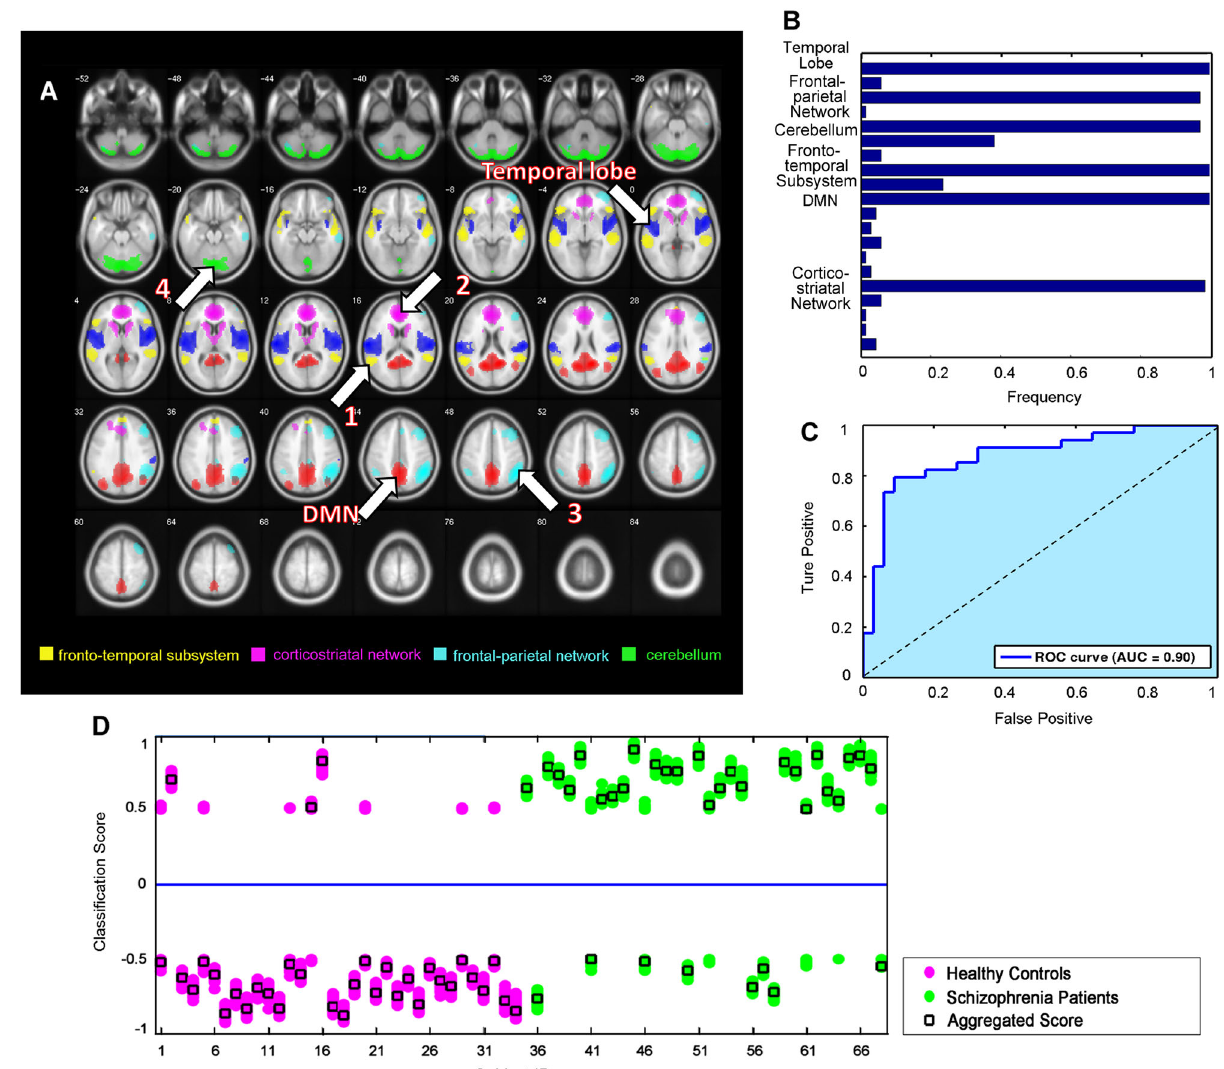
Fig. 1 Brain functional connectivity patterns differentiate between schizophrenia patients and healthy controls. a Spatial maps of the six selected IC components that could best discriminate between schizophrenia patients and healthy controls. These networks included the language network (fronto-temporal subsystem, yellow , IC 13), corticostriatal network ( pink , IC 5), frontal-parietal network ( bluish green , IC 18), cerebellum ( green , IC 16), default mode network (DMN, red , IC 11), and temporal lobe network (middle temporal gyrus, blue , IC 20). b Frequencies of the selected components in leave-one-out mode. Our results showed that the networks that were selected with the highest frequencies ( > 0.9) were those that constituted the most discriminative functional connectivity pattern. c Receiver operating characteristic curve of the most discriminative functional connectivity networks, illustrating good performance of the classi fi er. d Classi fi cation scores for each test subject, including scores that were yielded from the base classi fi ers and aggregated classi fi